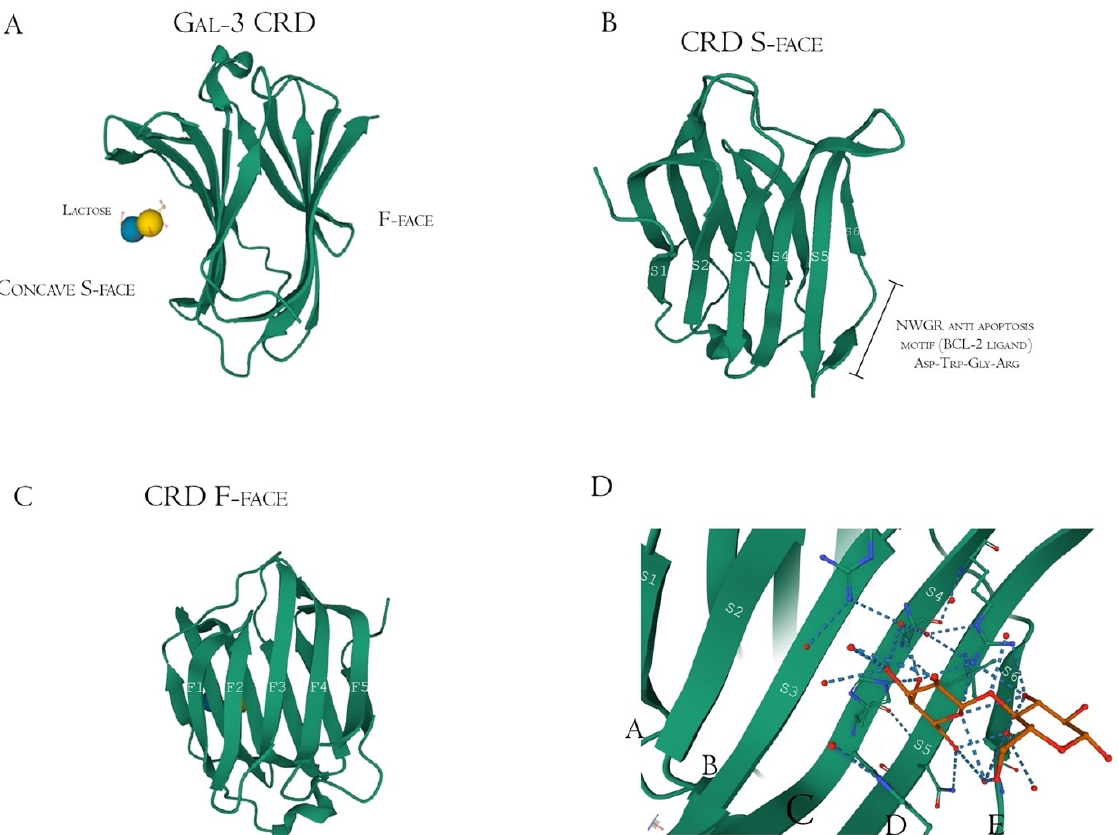
Figure 4. Galectin-3 crystalized tertiary structure X-ray diffraction, PDB ID 49RB [75,80,81]. ( A ) Gal-3 complete CRD, with the anti-parallel β -sheet sandwich; ( B ) CRD S-face β -sheets (S1–S6), which holds the ABCDE subsites. The NWGR motif is highlighted because of their biochemical importance; ( C ) CRD F-face β -sheets (F1–F5, also numbered as B-9, -8, -7, -2, and -11, respectively); ( D ) Schematic representation of β - D -galactopyranosyl-1,4- β -D glucopyranose ( β -Lactose) binding at the canonical S-face. The hydrogens atoms are colored as red, the hydrogen bonds as blue dotted lines, and the lactose chain as orange. The binding is stronger at the C subsite (between S4 and S5) amino acids and the β - D -galactopyranosyl residue.